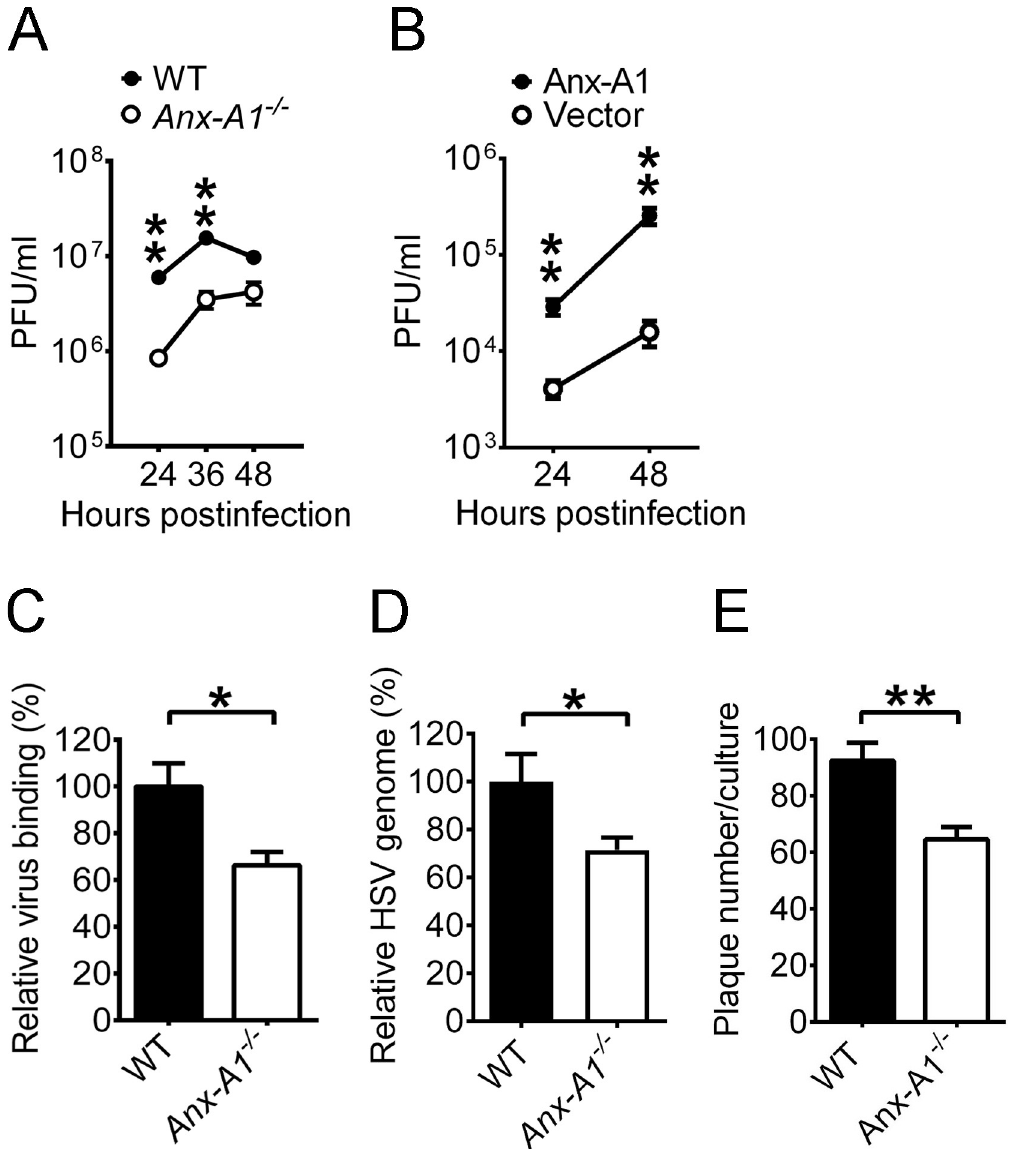
Fig 2. Cell surface Anx-A1 promotes HSV-1 attachment. ( A ) The HSV-1 yields in WT or Anx-A1 -/- MEFs (MOI = 0.01) at the indicated times are shown. ( B ) The viral yields in infected Anx-A1 -/- MEFs (MOI = 0.01) transfected with a control vector (Vector) or the vector expressing His-tagged Anx-A1 (Anx-A1) at the indicated times are shown. ( C and D ) The levels of HSV-1 binding on MEFs determined by plaque assay ( C ) or by real-time PCR ( D ) are shown. The level of HSV-1 binding to WT MEFs was set as 100%. ( E ) The numbers of HSV-1 plaques formed on MEFs monolayers after infection with 400 PFU/ monolayers of virus are shown. Data show the mean + or ± SEM of > 4 samples per group. � P < 0.05 and �� P < 0.01. unknown mechanism in human foreskin fibroblasts [19], suggesting the potential of cell sur- face Anx-A1 to mediate virus binding. We studied the interaction between HSV-1 and Anx- A1 and observed colocalization of HSV-1 and Anx-A1 on the cell surface using immunofluo- rescence staining (S4 Fig). To investigate whether Anx-A1 affects HSV-1 attachment, MEFs were infected with HSV-1 for 1 h at 4˚C, washed at 4˚C, immediately stored at -80˚C, and sub- jected to determine the numbers of virus binding via plaque assay as described [20] or via real-